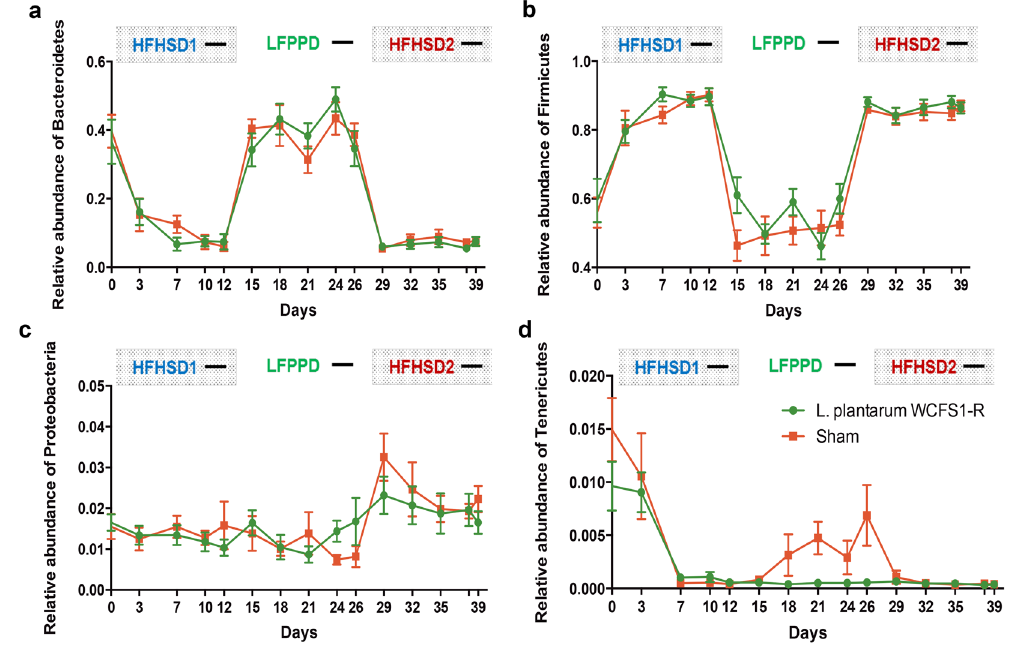
Figure 2. Diet switches result in significant changes to major bacterial phyla in the mouse intestine. Bacteroidetes ( a ), Firmicutes ( b ), Proteobacteria ( c ) and Tenericutes ( d ) are shown. Black dashes indicate the days when the mice received L . plantarum